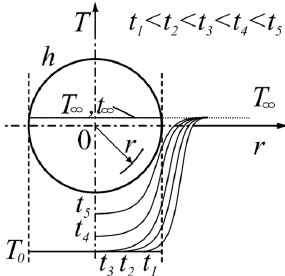
Figure 2. A cool sphere warming in a warm environment adapted from [11]. The x-axis indicates the radial position, and the y-axis indicates temperature. The in- itial temperature of the sphere before entering the fluid is denoted as T (cid:2868) and the final temperature as T (cid:2998) . Profiles t (cid:2869) to t (cid:2873) display how the temperature changes as a function of time and radial position within a spherical object. Temperature profiles are a function of several important boundary conditions. First, a symmetric temperature profile assumes a constant value of high heat transfer over the entire surface of the object. Second, the thermal properties of the object must be considered as well as the characteristics of the fluid flow. Third, geometry has a great influence on the temperature evolution within the object. Figure 3 below illustrates the solution for the transient temperature field as an error function approximated with a series of transcen- dental functions. The plot below is for the center of a sphere of arbitrary material and heat transfer conditions. Figure 3. The analytical transient temperature change at the center of a sphere adapted from [11]. The x-axis represents non-dimensional time and is scaled using the thermal diffusiv- ity κ (m 2 /s) of the chosen material and scaled by the characteristic length, r (m), i.e., the Fourier number: Fo = κ ⋅ t r (cid:2870)